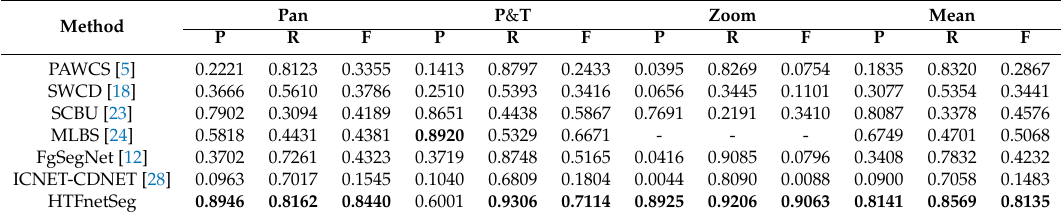
Table 6. Evaluation values of seven methods on the test dataset. The best results are shown in bold . Pan P & T Zoom Mean Method P R F P R F P R F PAWCS